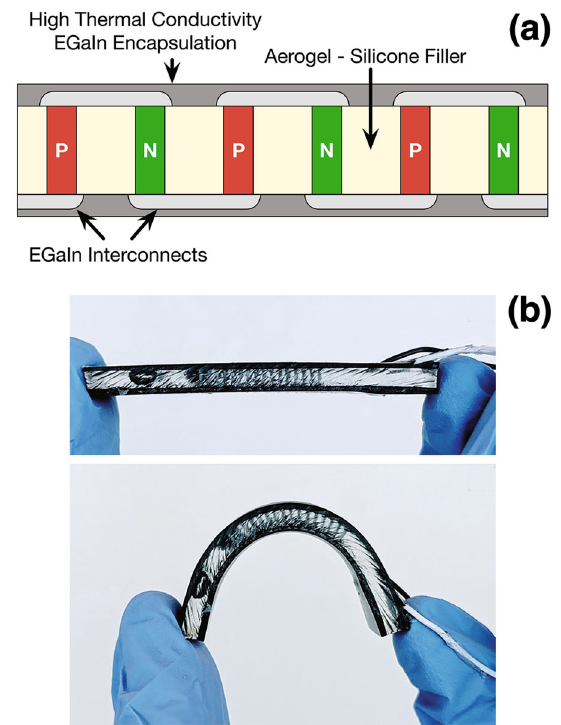
Fig. 4 Flexible TEG. a Illustration highlighting the three key components of a fl exible module including the EGaIn liquid metal interconnects, high thermal conductivity EGaIn encapsulation elastomer and low thermal conductivity aerogel – silicone fi ller. b A typical module fl exed between two fi